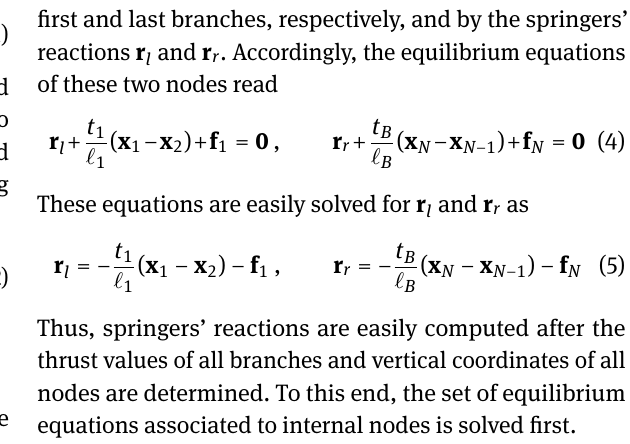
Figure 2: Horizontal thrust thrust line are loaded by the thrust forces associated to